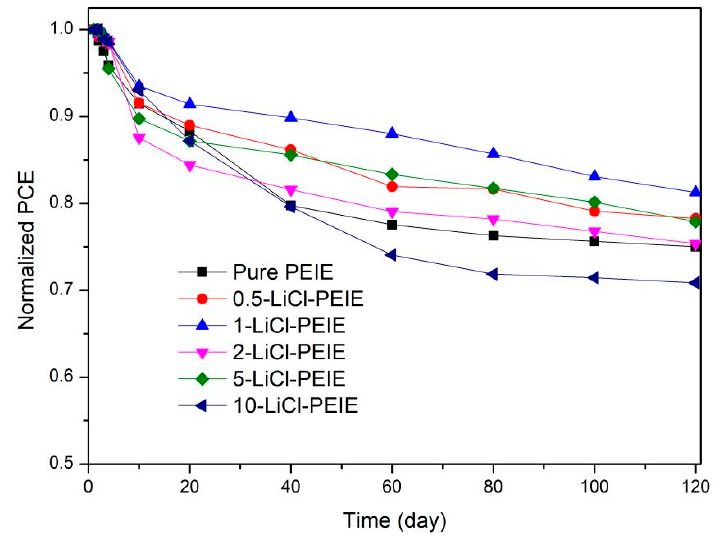
Figure 6. Long-term stability of the unencapsulated devices with different ETLs in N2 atmosphere with one sun illumination at 25 °C.